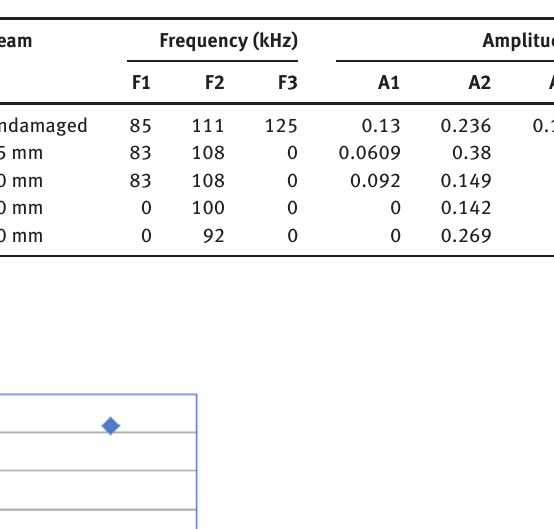
Table 4: Section 2 frequencies and amplitudes.